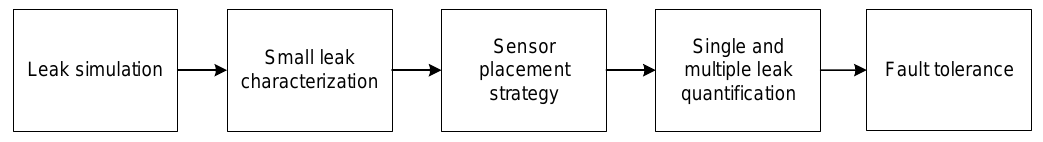
Figure 1. The diagram of our proposed